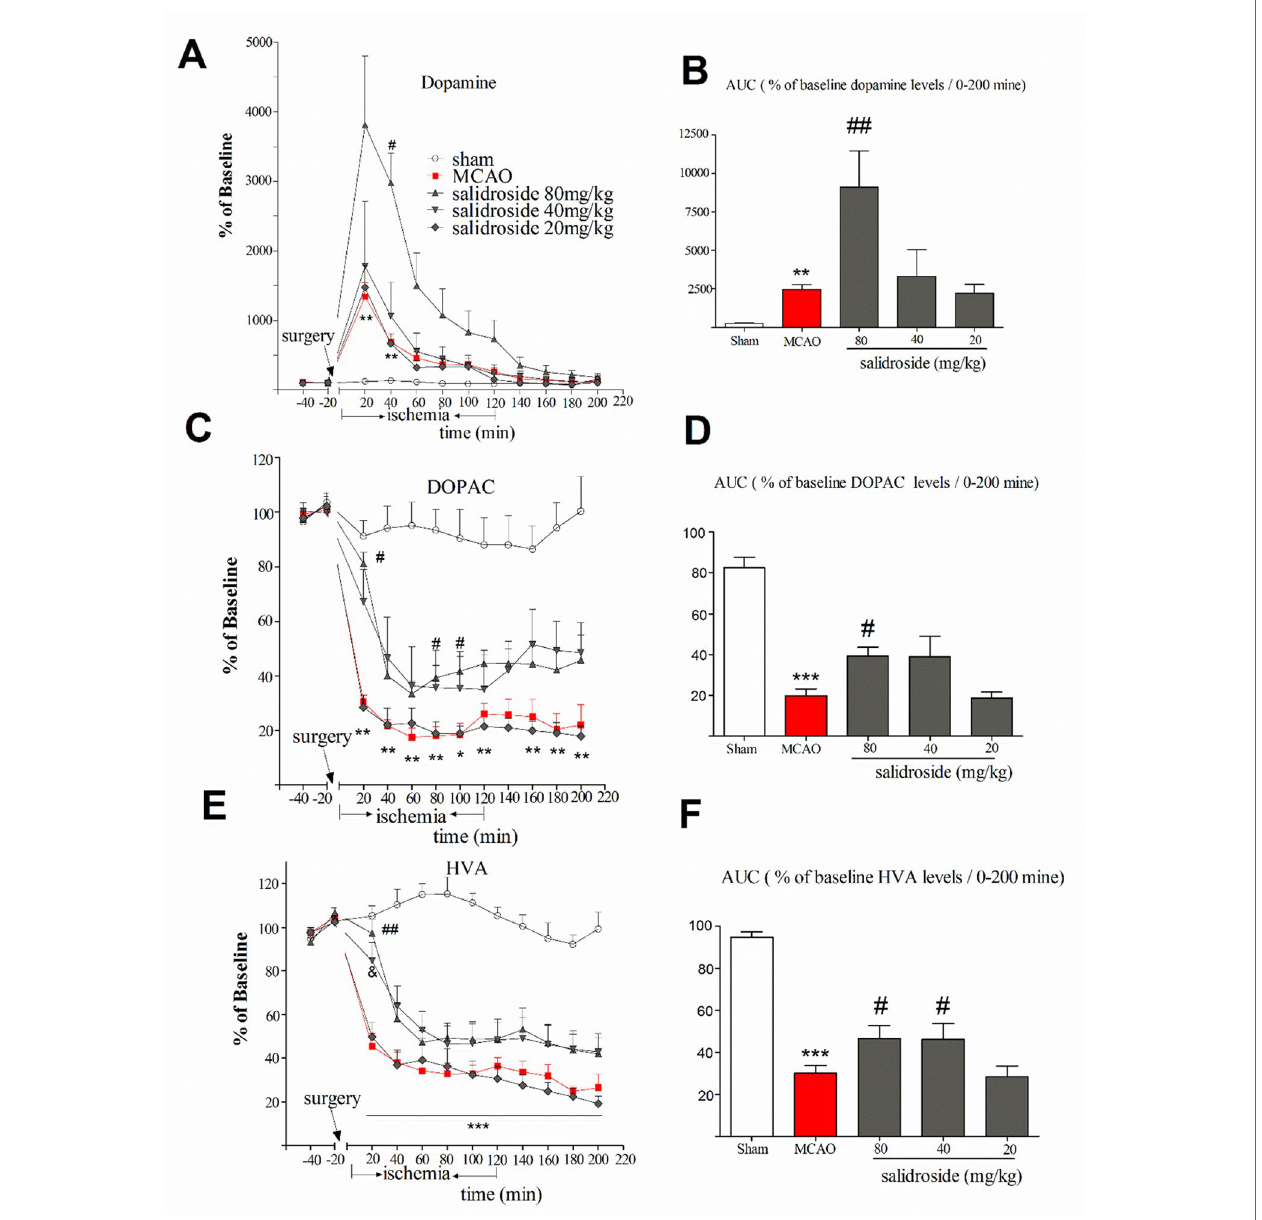
FIgURE 3 | Time-course percentage changes in extracellular DA, DOPAC, and HVA levels in the striatum during cerebral ischemia/reperfusion under a single i.p. injection of saline solution or salidroside (80 mg/kg, 40 mg/kg, and 20 mg/kg). Extracellular levers of DA, DOPAC, and HVA in the striatum were monitored for 4 h; their levels are expressed as percentage of baseline (a , C , E) . The area under curve (AUC) for extracellular percentage of baseline DA, DOPAC, and HVA levels was calculated from their release curves and was plotted in the striatum over a period of 200 min (0-200 min) (B , D , F) . The arrow indicates the surgery of MCAO. Each column represents the mean and the SEM, n = 7. ** p < 0.01, *** p < 0.01 compared to the sham group; # p < 0.05, ## p < 0.01, & p = 0.058 compared to the MCAO group. AUC area under the curve, DA dopamine, DOPAC 3,4-dihydroxyphenylacetic acid, HVA homovanillic acid, MCAO middle cerebral artery occlusion, SEM standard error of the